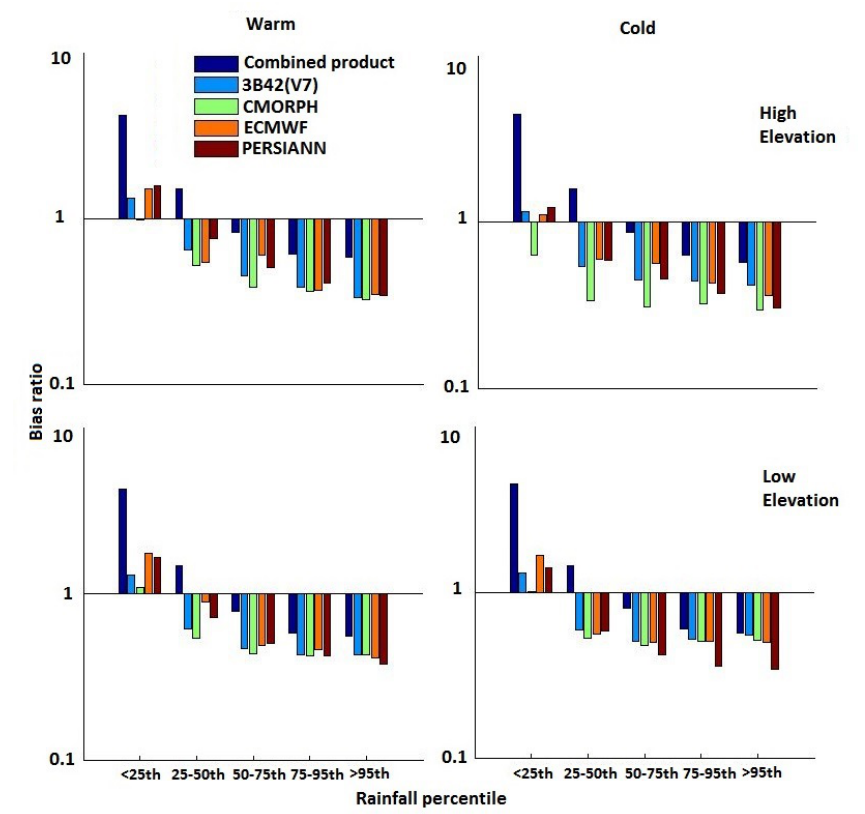
Figure 7. Bias ratio for warm and cold